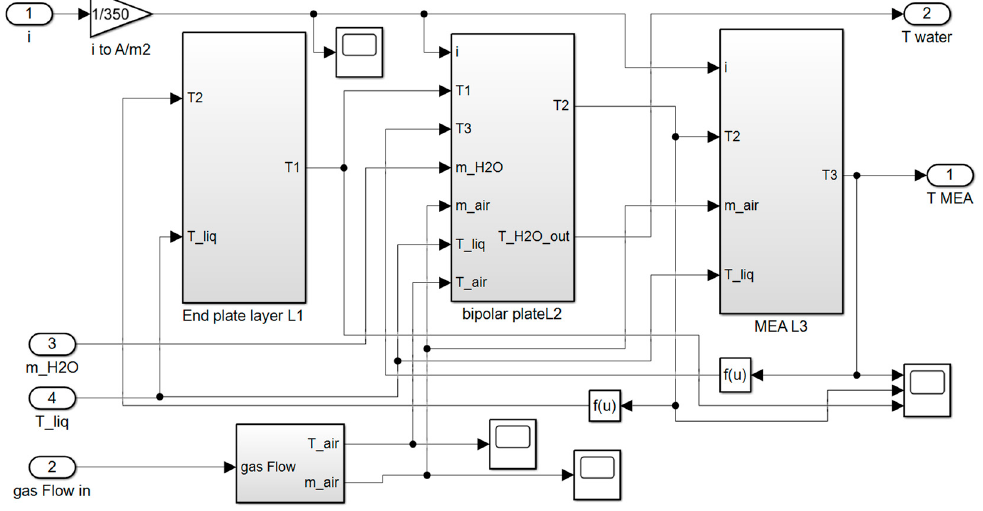
Figure 3. Heat transfer model diagram of fuel cell.